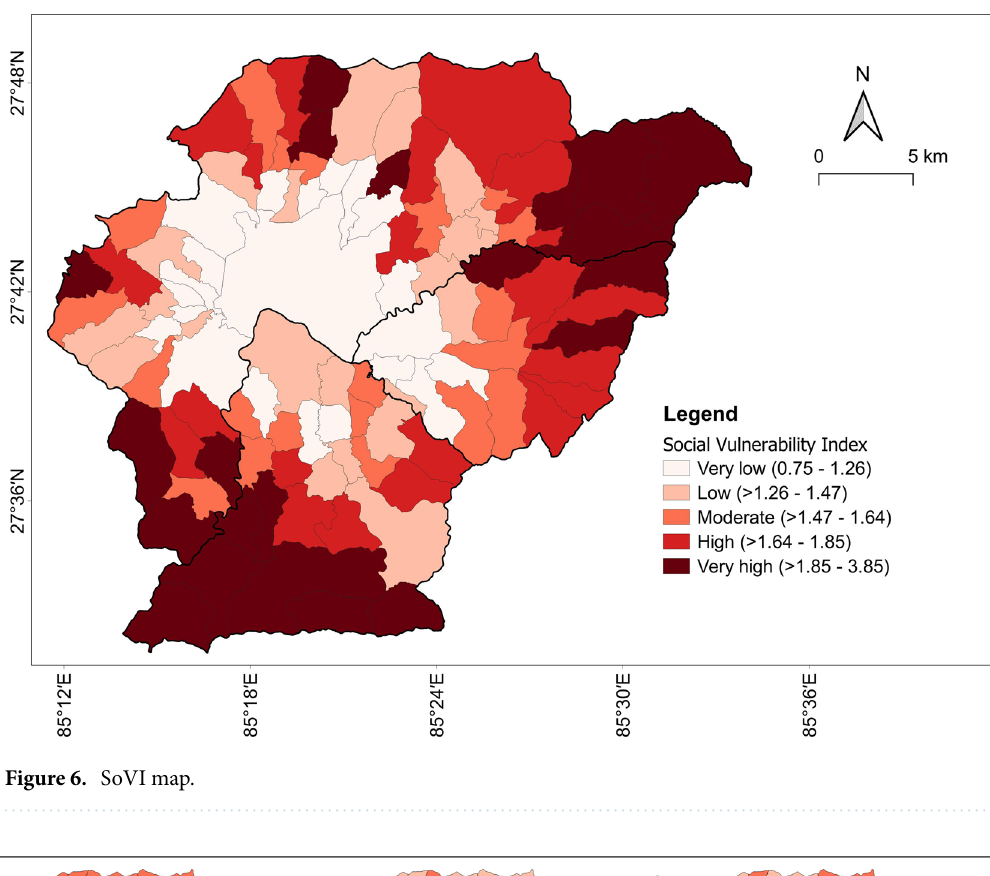
Figure 6. SoVI map.